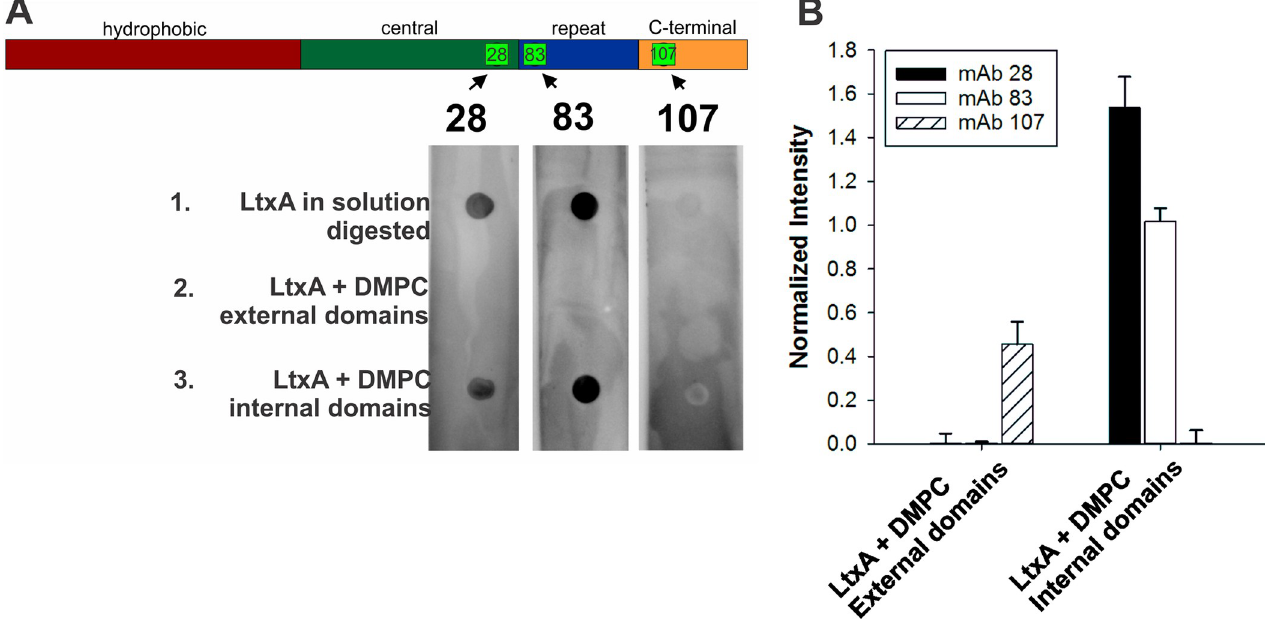
Fig 5. Dot blot analysis of exposed (external) and protected (internal) regions of LtxA in solution and in DMPC membranes. (A) Dot blot analysis of 1) trypsin-exposed LtxA, 2) digested domains of LtxA-liposomes, and 3) undigested domains of LtxA-liposomes. (1) Full-length, digested LtxA was used as a control (Dot #1). Antibodies 28 and 83 were able to detect their epitopes in full-length LtxA; however, the epitope for antibody 107 was digested in the typsin treatment and therefore, undetectable. (2) LtxA was incubated with DMPC liposomes for 30 mins and then digested with trypsin. The peptides resulting from this digestion, derived from domains of LtxA residing outside of the liposome, were separated and spotted on the nitrocellulose (Dot #2). None of the antibodies detected their epitopes, indicating that the epitopes for mAbs 28 and 83 reside inside the membrane. The epitope of mAb 107 is not detected, indicating either it is digested (thus, residing outside of the liposome) or is protected inside the liposome. (3) Finally, the liposomes, containing the domains of LtxA residing inside the liposomes were spotted on the nitrocellulose (Dot #3). Antibodies 28 and 83 detected their epitopes, confirming that these two epitopes are located in a domain of LtxA that is located inside the liposome. The epitope to mAb 107 was not detected, indicating that this epitope is not located within the membrane, and must therefore be located outside of the membrane. (B) Quantification of dot blot intensities, determined using ImageJ. Each bar represents detection of LtxA by one of three monoclonal antibodies, mAb 28 (black), mAb 83 (white), mAb 107 (hashed). Each intensity is normalized by the intensity of the digested LtxA in solution dot detected by the respective antibodies.